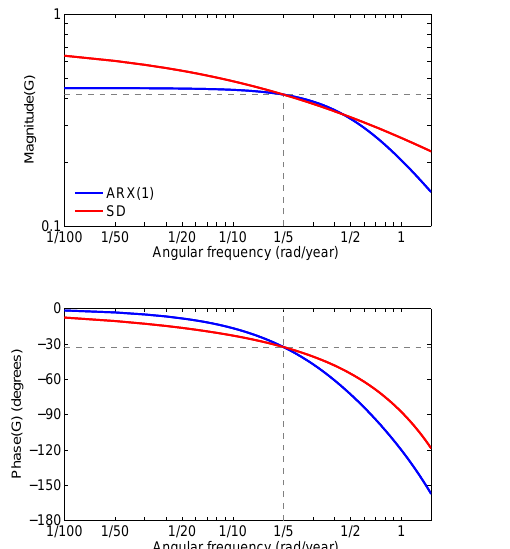
Figure 4. Bode plot (as in Fig. 3) comparing the first-order linear model (ARX(1); Eq. 7) and a semi-infinite diffusion model (SD; Eq. 8). Values for ARX(1) are β = 0.447, τ = 1.946, and D = 1.0. Values for SD are β d = 0.732, τ d = 4.063, and D = 1.0. Values are chosen so that the magnitude and phase are identical for both mod- els at ω = 0.2radyr − 1